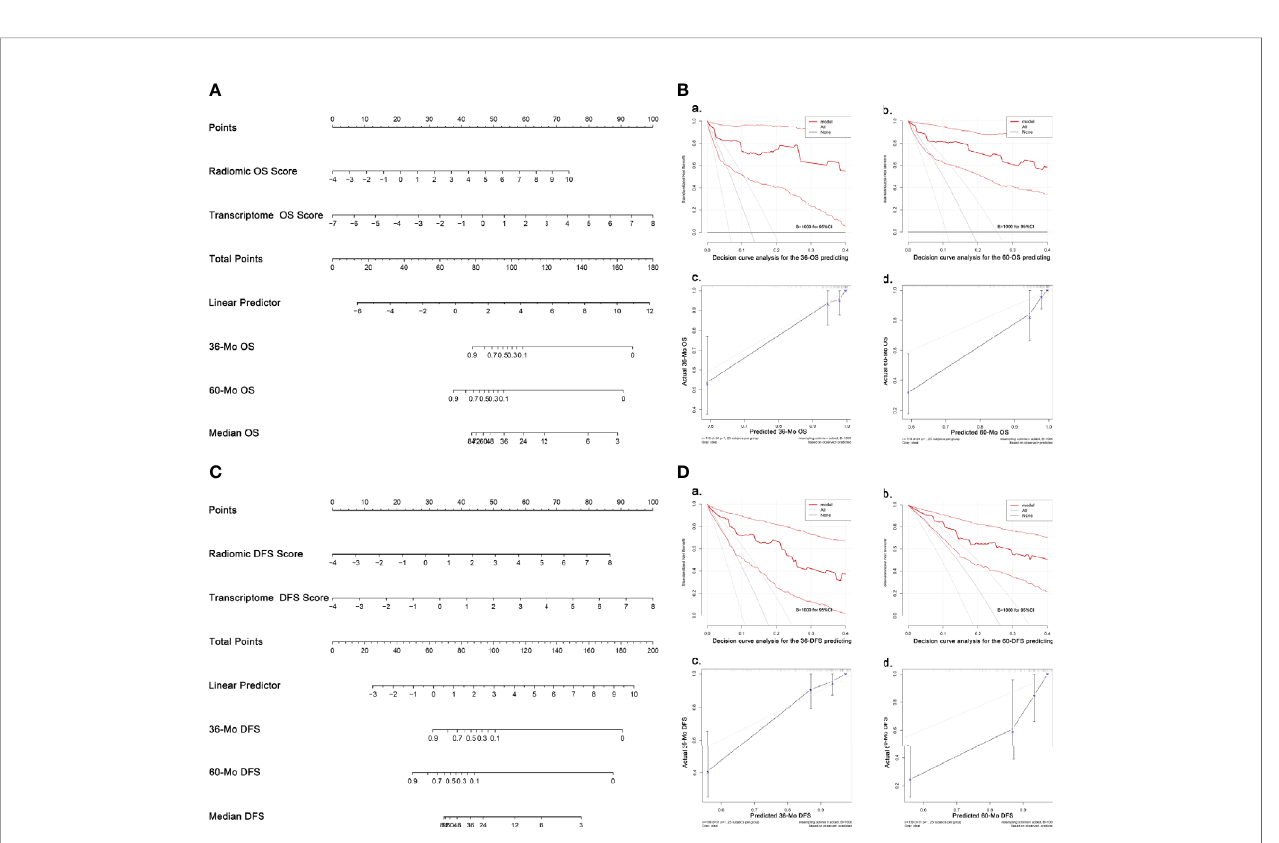
FIGURE 5 | Nomograms and validation of the OS- and DFS-predicting models. (A) Nomogram predicting OS. (B) Validation of the OS-predicting model: (A, B) DCA of the nomogram predicting 36-Mo and 60-Mo OS. (C, D) Calibration curves showing the probability of 36-Mo and 60-Mo OS between model prediction and actual observation. (C) Nomogram predicting DFS. (D) Validation of the DFS-predicting model: (A, B) DCA of the nomogram predicting 36- Mo and 60-Mo DFS. (C, D) Calibration curves showing the probability of 36-Mo and 60-Mo DFS between model prediction and actual observation. In DCA plot, the X-axis shows the threshold probabilities while the Y-axis shows the net bene fi t (adding true positives and subtracting false positives). The black horizontal line along the x-axis assumes that no patients died (or progressed) whereas the gray line assumes that death (or progression) occurred in all cases. DCA and calibration curve analyses were carried out using 1000 bootstrapping replications. The bootstrapped 95%CIs of the decision curves and calibration curves are present. OS, Overall survival; DFS, Disease-free survival; DCA, Decision curve analyses, CI, Con fi dence